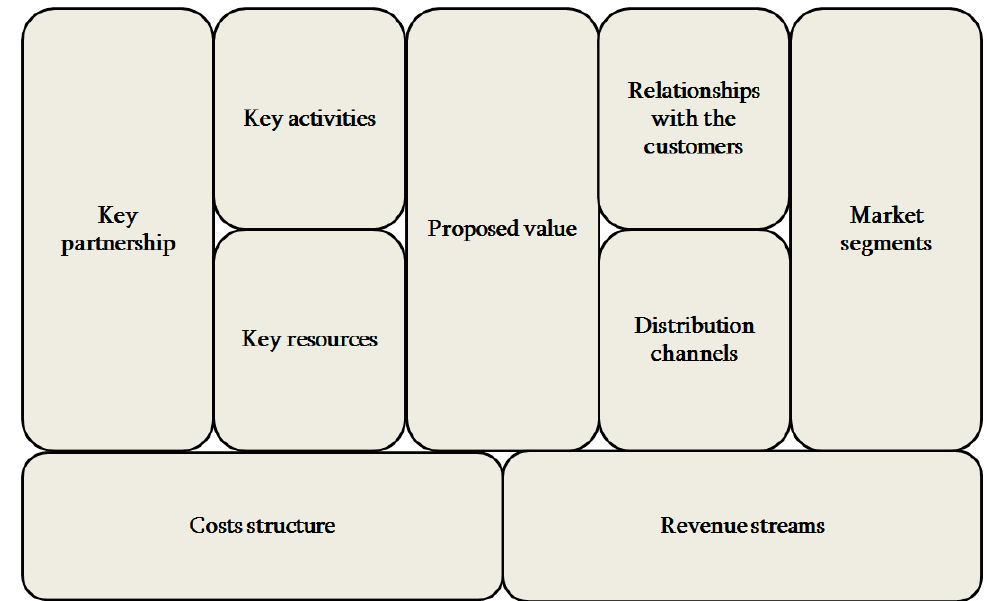
Figure 1. Template of CANVAS business model. Source: own study based on the CANVAS concept [10].